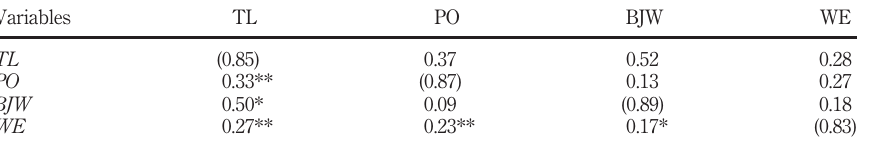
Table 2. Discriminant